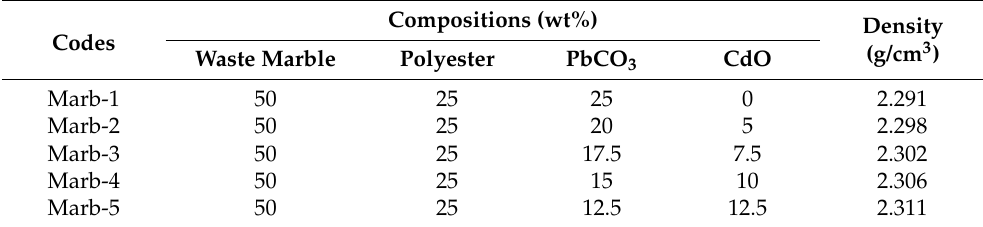
Table 3. Chemical composition of the produced new radiation shielding